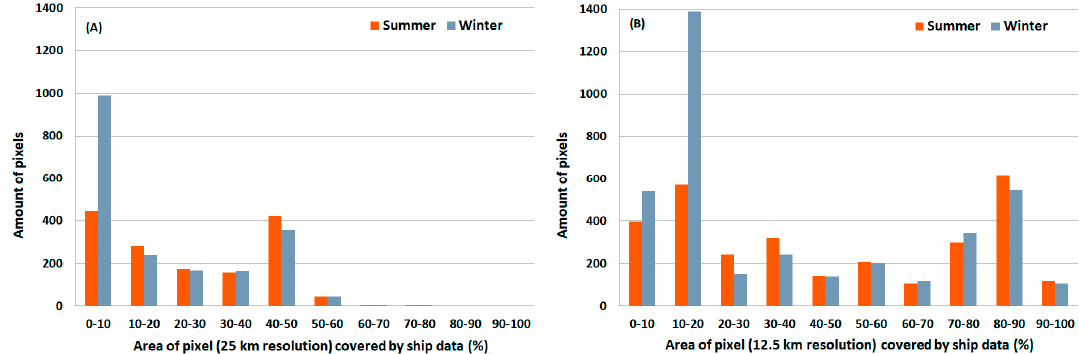
Figure 5. Distribution of ship data coverage area in pixels of 25 km ( A ) and 12.5 km ( B ) resolution in summer and winter.